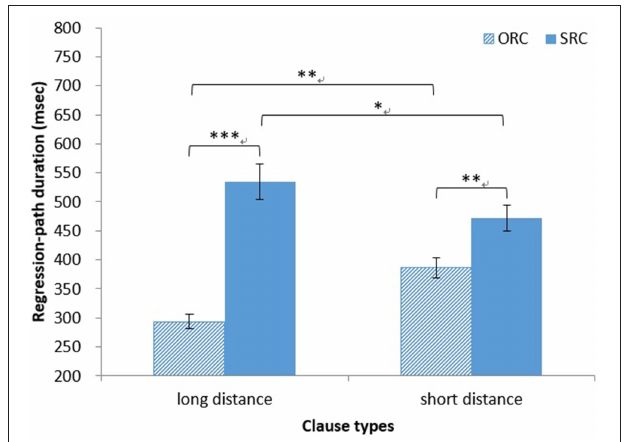
FIGURE 2 | Chinese group: gaze duration for HNs in RCs. *** p < 0.001 .